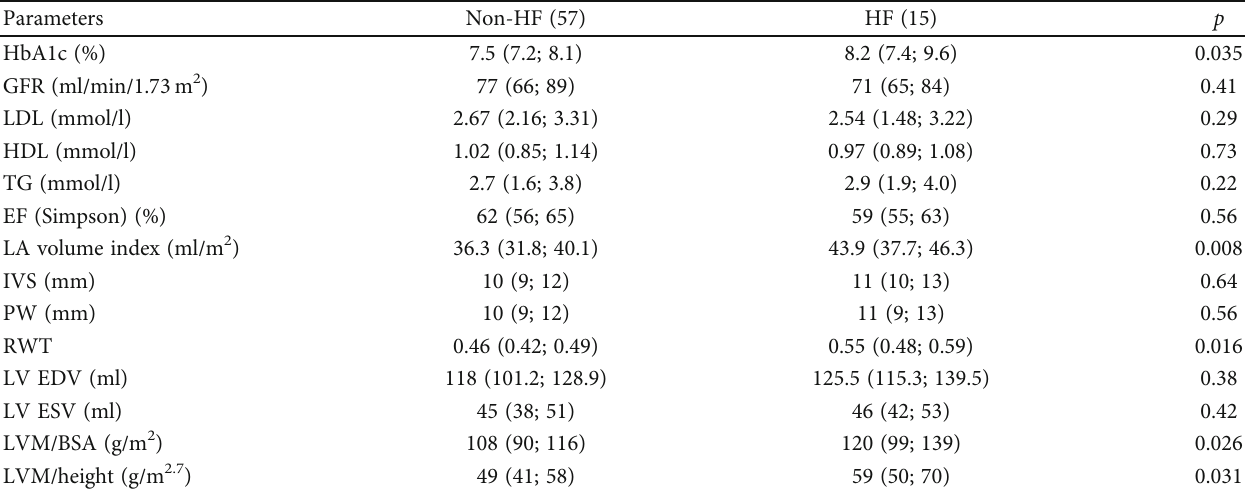
Table 3: Comparison of echocardiography and laboratory results between groups, Me (25;